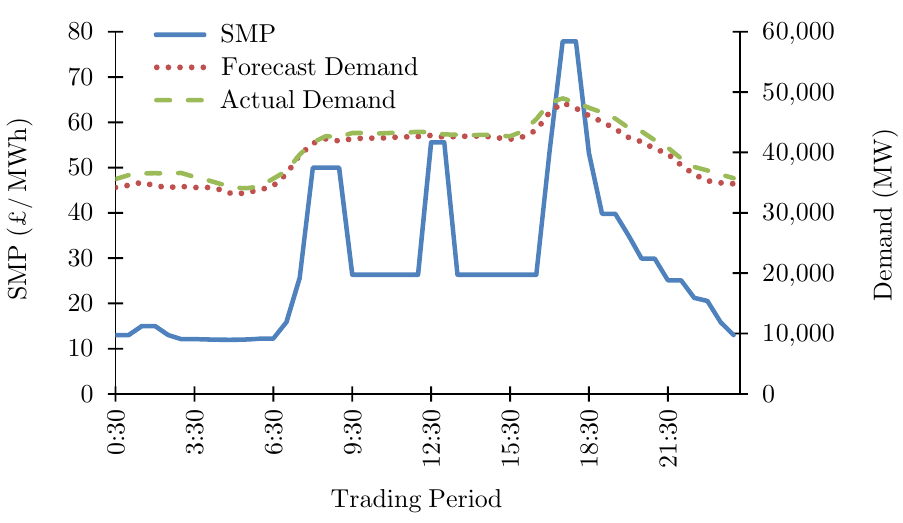
Figure 5. SMP, forecast demand, and actual demand (6 January 2000).